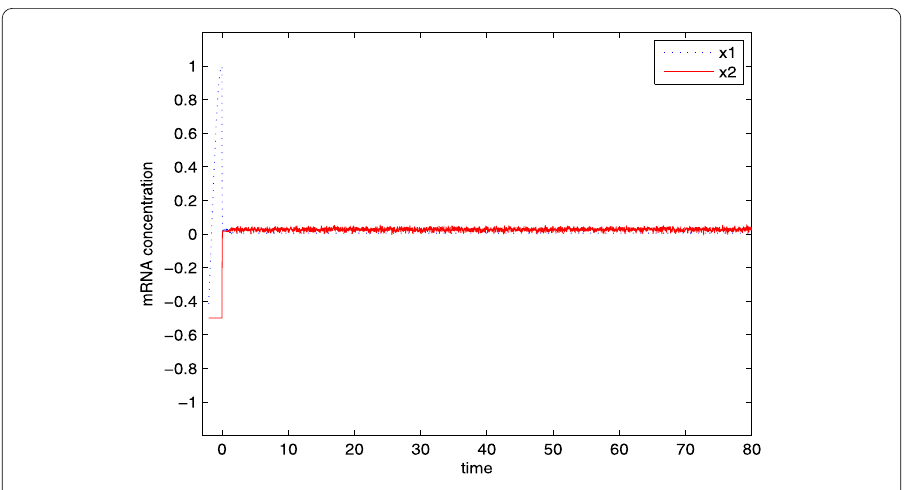
Figure 1 State responses of the mRNA concentration with impulsive control (cid:17) 0.65 K =